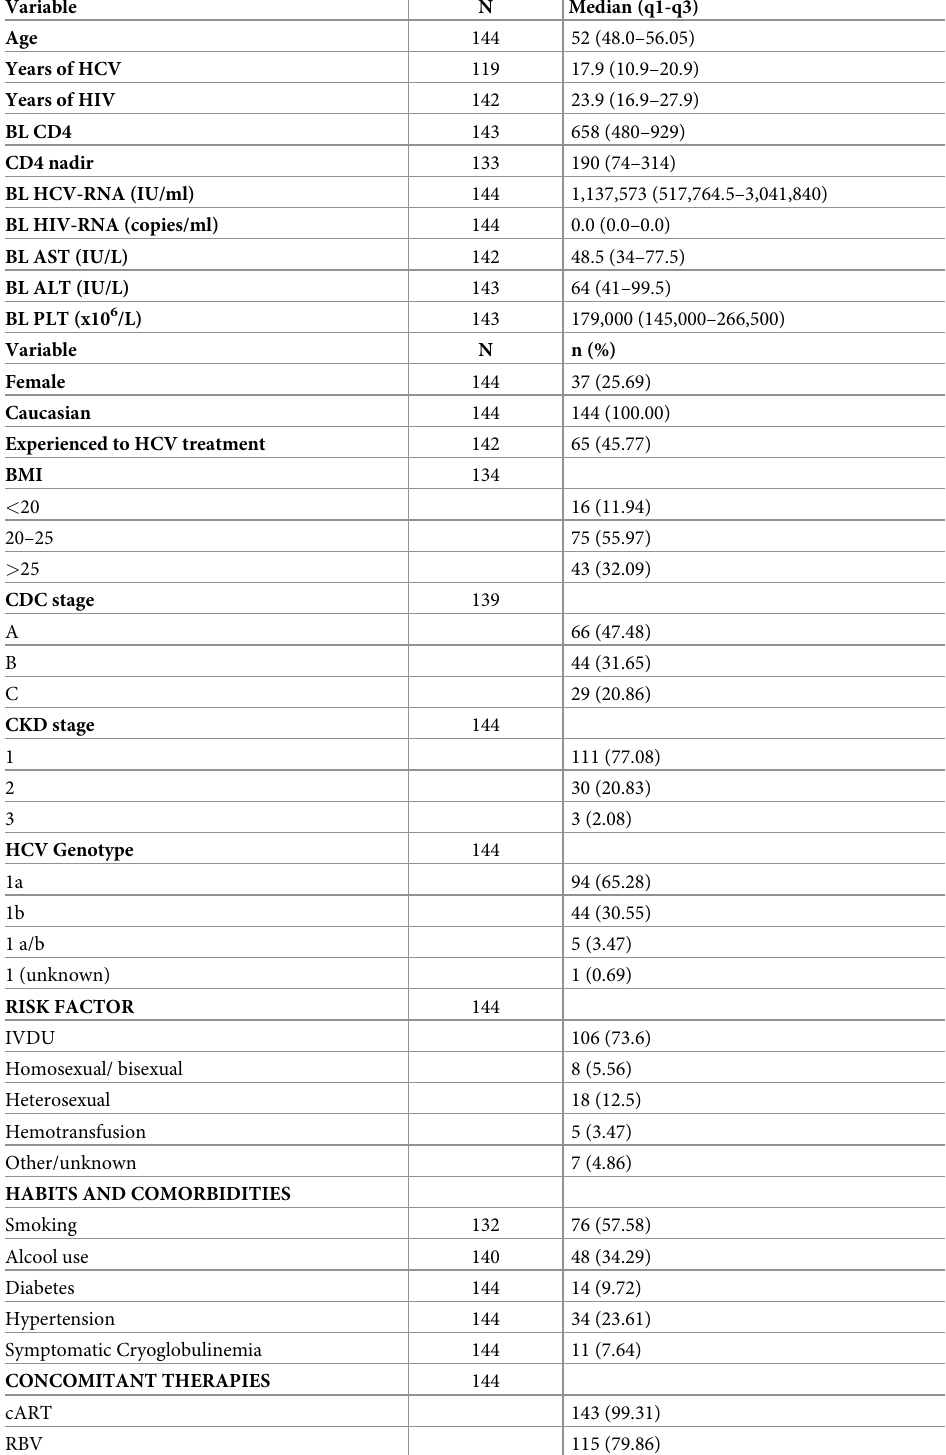
Table 1. General characteristics of the study population at baseline (BL). Data are expressed as medians (1st - 3rd quartiles) or absolute frequencies